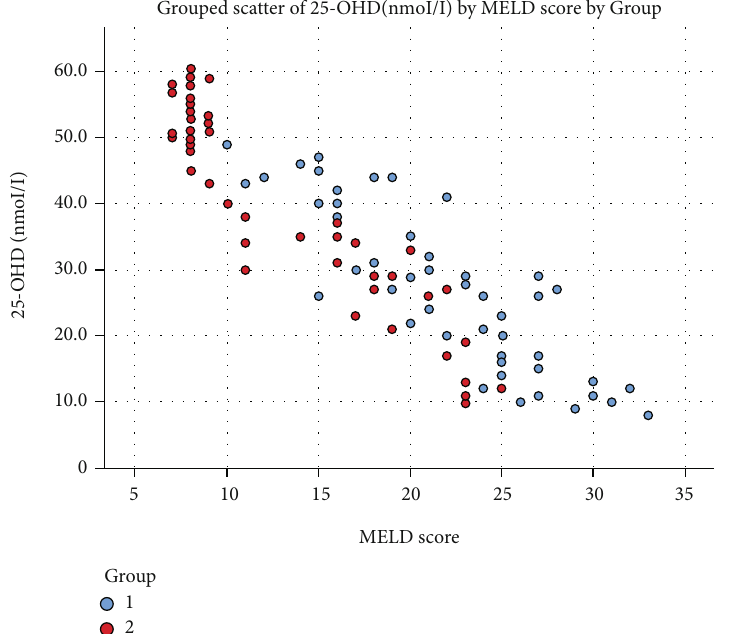
Figure 5: Grouped scatter plot showing the correlation between the 25-OHD level and MELD score (A fifi , Hussein, and Rizk,